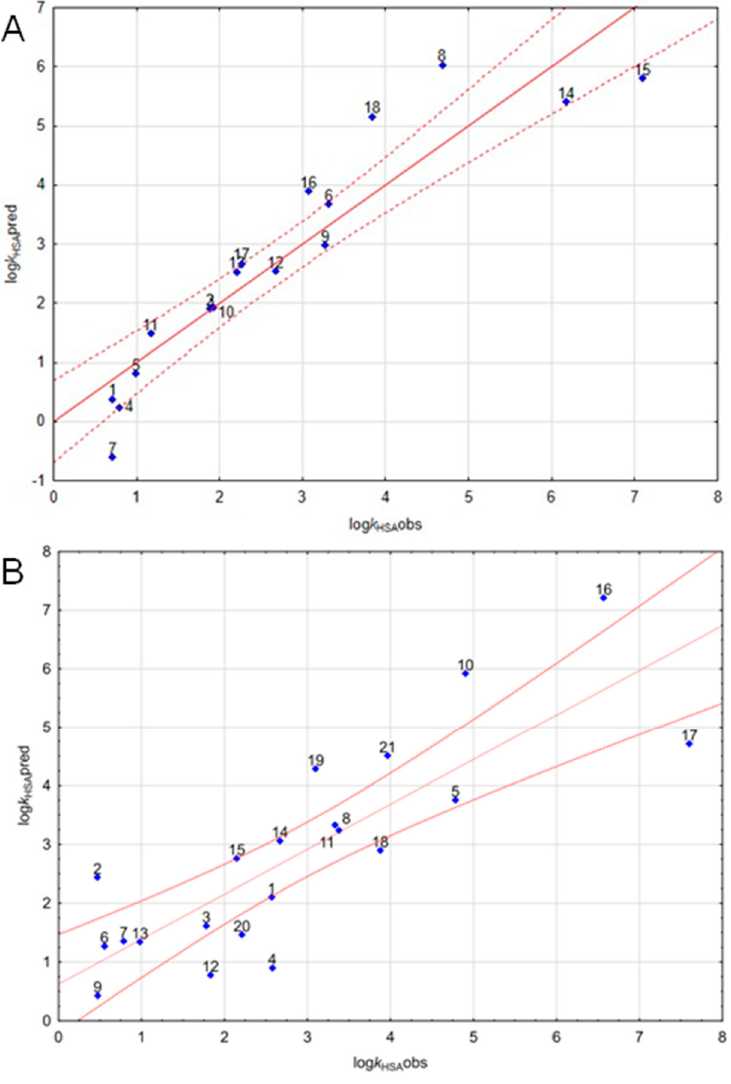
Figure 3. Comparison of experimentally determined log k HSA values and the corresponding parameters predicted by MLR-QSRR models: ( A ) model 1, ( B ) model 2.